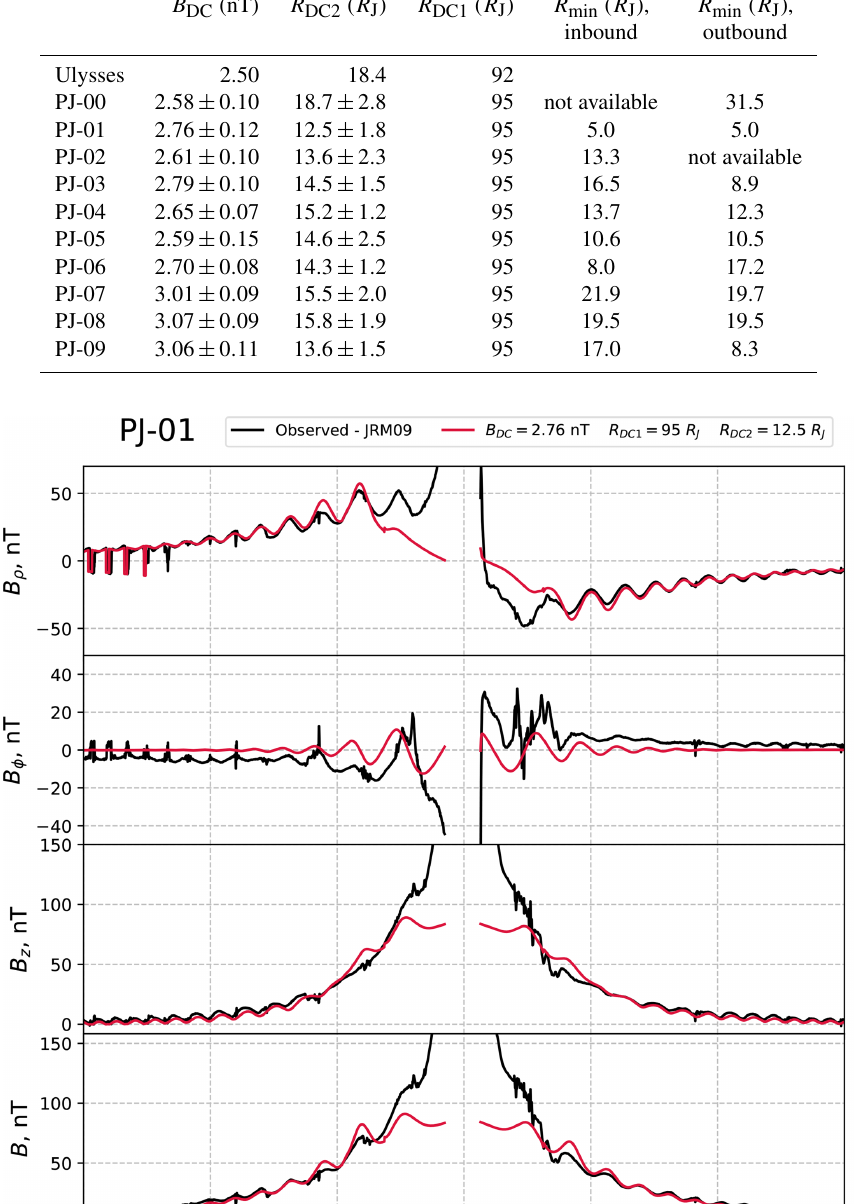
tude plotted versus radial distance, where the same model applies to both inbound (left side) and outbound (right